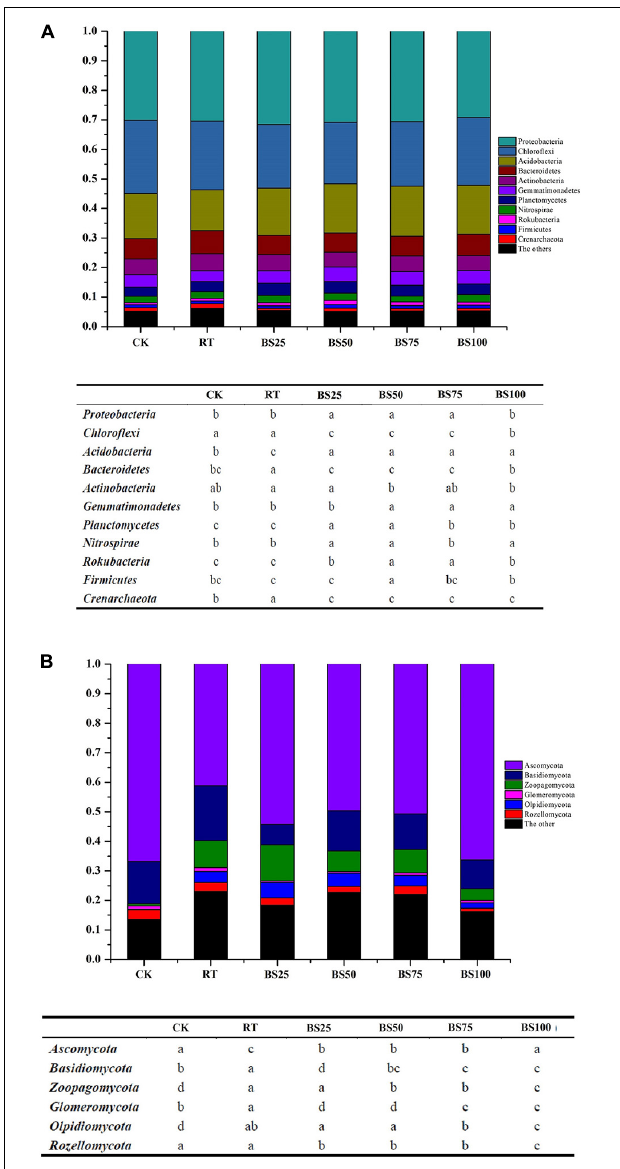
FIGURE 2 | Phylogenetic classification of dominant bacterial (A) and fungal (B) phyla and their summarized phyla with statistical differences in different treatments. Different letters at each phylum indicate significant differences at P < 0.05 according to the LSD